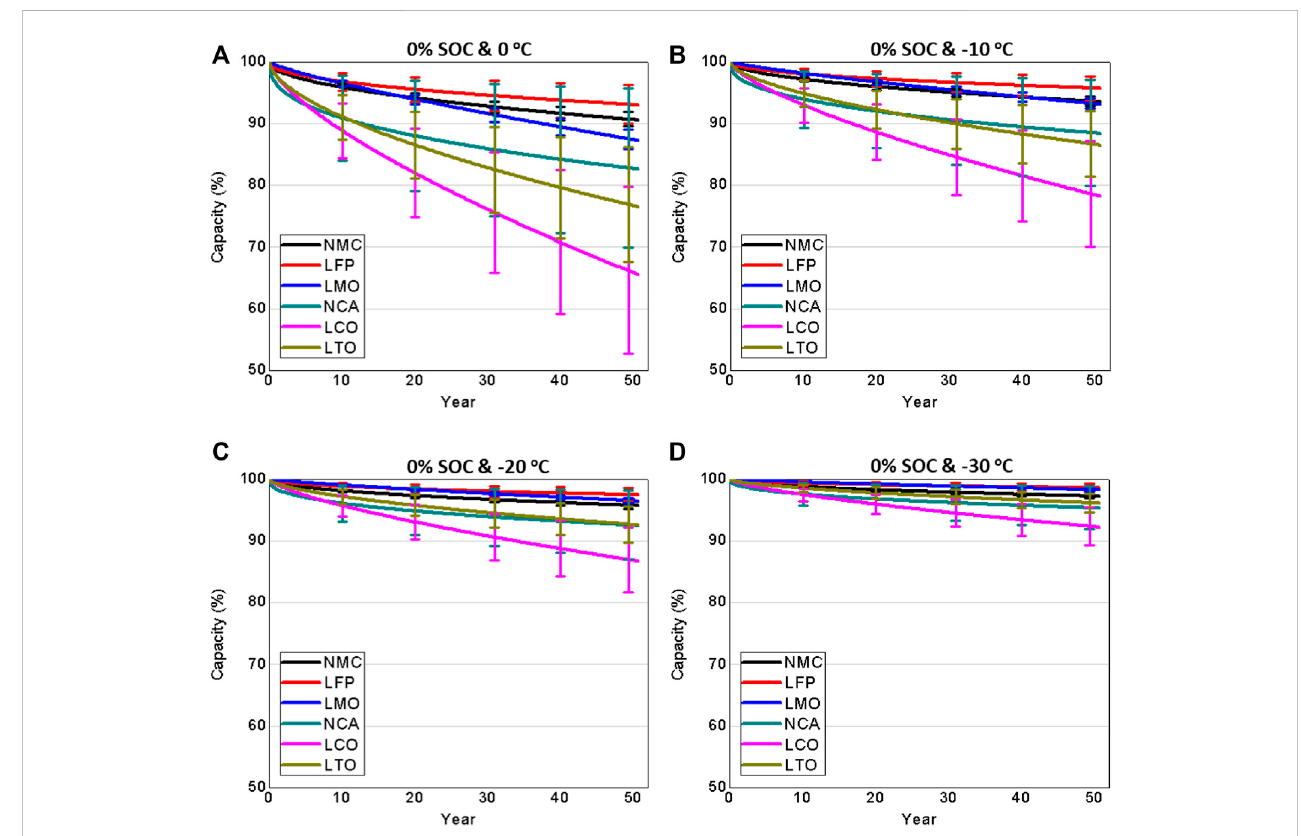
FIGURE 5 Capacity degradation ofvariousLIB chemistries at variousstorage conditions (A) 0% SOC and 0 C (B) 0%SOC and – 10 ° C (C) 0% SOC and – 20 C and (D) 0% SOC and – 30